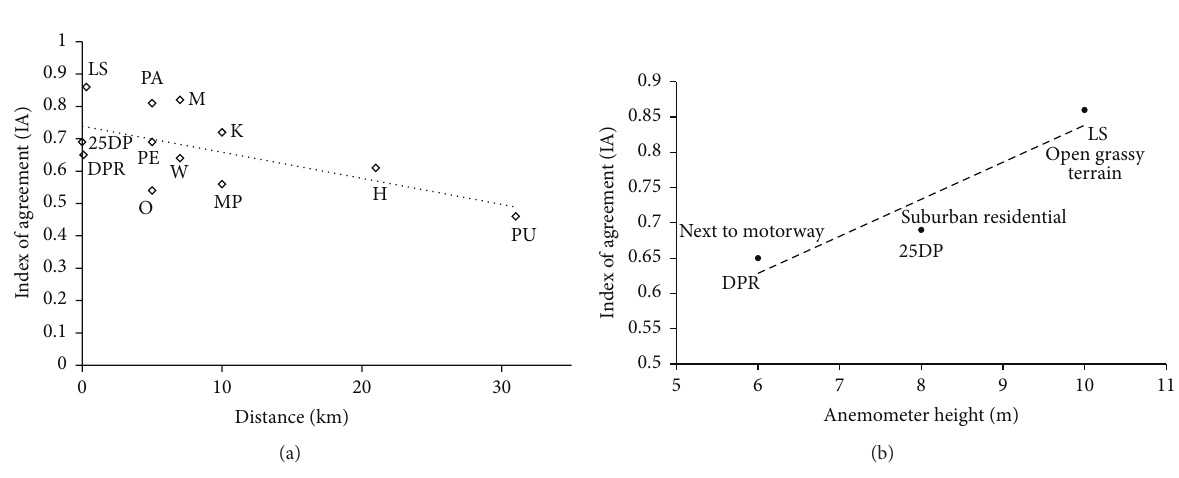
Figure 6: (a) The effect of distance to the wind site on model performance at 25DP. (b) The effect of anemometer height and openness on the model performance at 25DP with wind data from three on-site